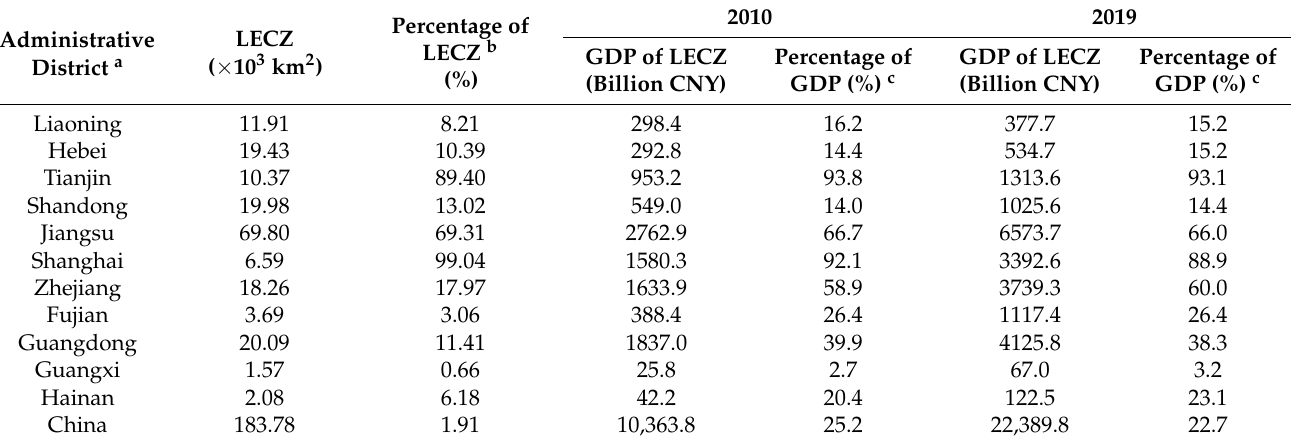
Table 2. GDP statistics in the LECZ of provinces of China.